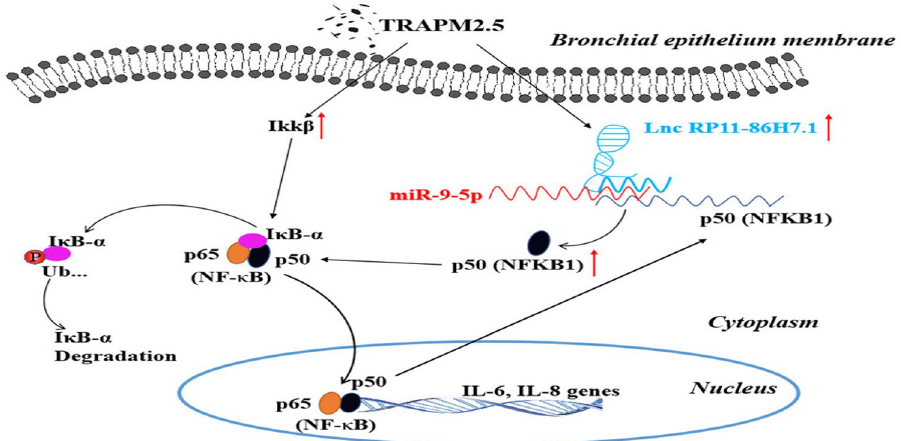
Figure 8. Schematic depicting the mechanism through which the lncRNA RP11-86H7.1 promotes TRAPM2.5- induced airway inflammation by acting as a ceRNA of miRNA-9-5p to regulate NFKB1 expression in bronchial epithelial cells, which is drawn using Microsoft PowerPoint 2019 software (https ://www.micro softs tore.com.cn/ offic e/offic e-home-stude nt-2019/p/79g-05015